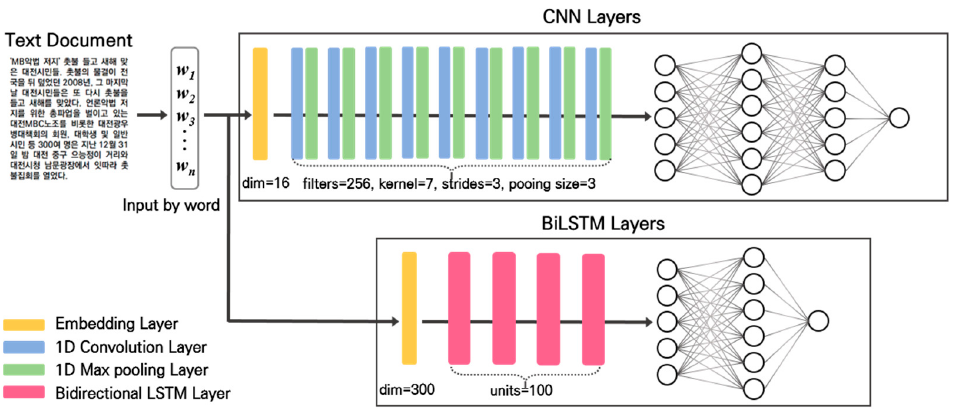
Figure 1. The proposed CNN layer and BiLSTM layer-based models.